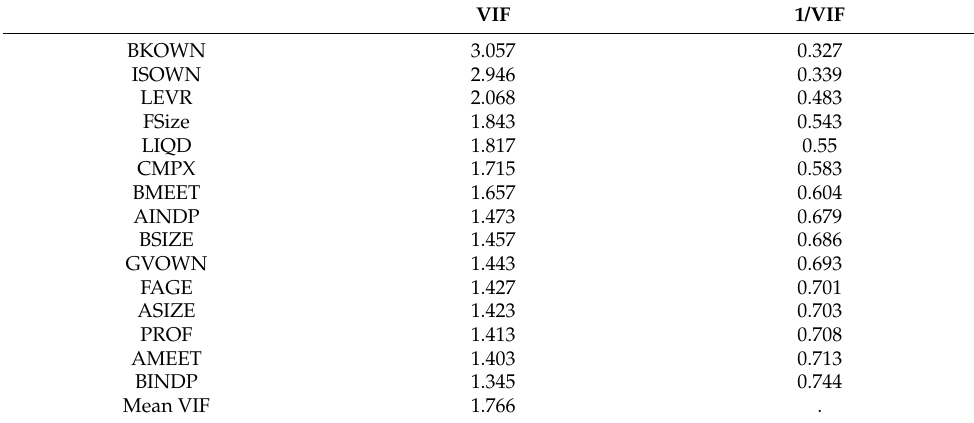
Table 5. Variance inflation factor.